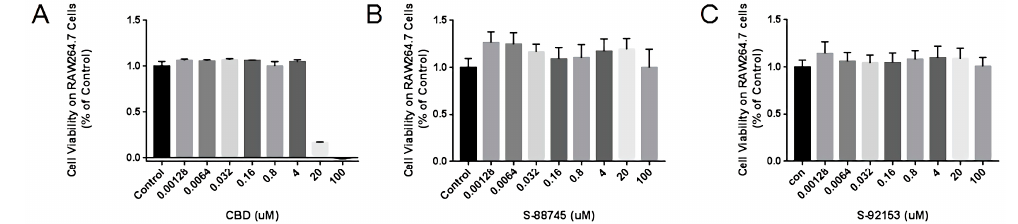
Figure 4. Cytotoxicity of ( A ) CBD, ( B ) S-88745 and ( C ) S-92153, on RAW264.7 cells. RAW264.7 cells were treated with cannabidiol, S-88745 or S-92153 for 24 h, and MTT assay was carried out to detect the cell viability. The control group was not treated with CBD, S-88745 and S-92153. The experiments were repeated three times. Each bar illustrates the average ± standard deviation (SD) counted from three experiments.